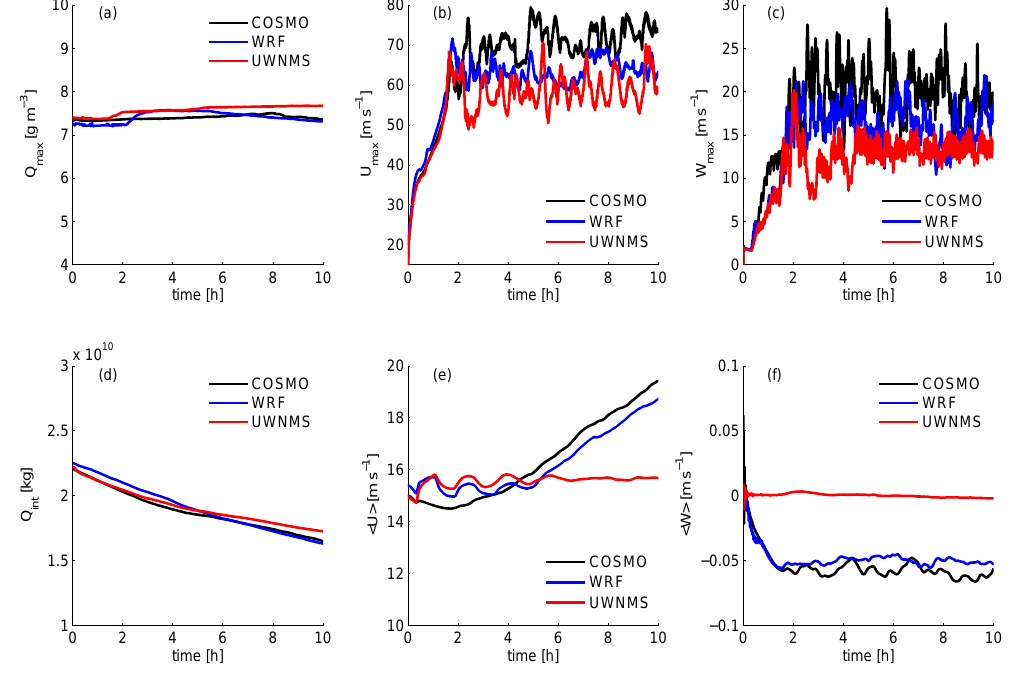
Fig. 13. Same as Fig. 3 but for simulation SIM 3 CC.